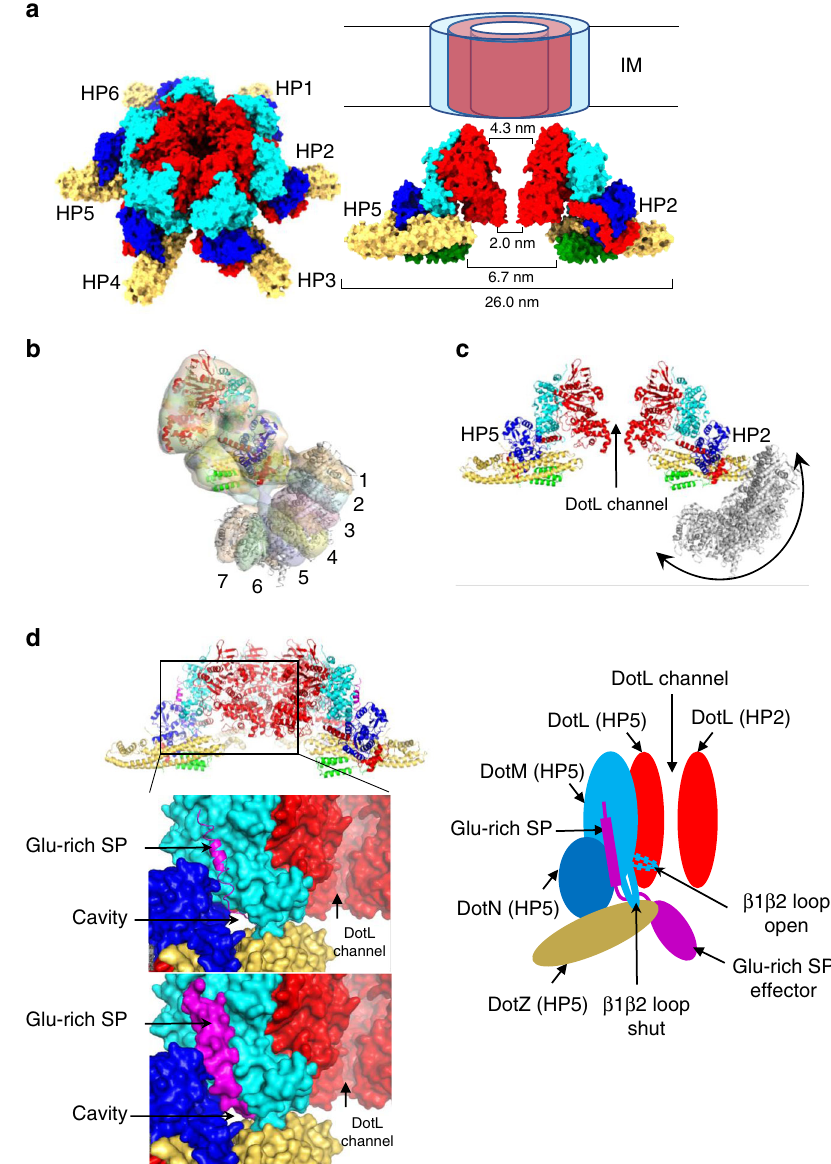
Fig. 5 The T4CC hexamer and effectors recruitment and trajectory. a Tilted and side views of the T4CC hexamer. “ HP ” refers to the hetero-pentameric unit of the T4CC core, 6 units of which form the T4CC hexamer. For the side view, only two hetero-pentameric core units are shown (HP2 and 5). The dimensions of the various parts of the T4CC channel are indicated. Proteins are shown in surface representations color-coded as in Fig. 1e. The trans- membrane segments of DotM and DotL are shown schematically as cylinders inserted through the IM. No structural information is yet available for this channel. b Superposition of 7 maps of the T4CC including IcmSW. The map superposition reports on 7 different positions for the IcmSW module. Map details are reported in Supplementary Fig. 5c. c Superposition of the various IcmSW module structures (in grey ribbon) derived from the maps shown in b in the context of the T4CC hexamer. Two opposite hetero-pentameric units (HP2 and 5) are shown in ribbon color-coded as in Fig. 1e, but only one (HP2) reports on the various IcmSW positions that we observe. The double arrow indicates the trajectory of the IcmSW module, which brings the module in and out of the DotL channel. d Access of Glu-rich SP-containing effectors to the DotL channel. Left, upper panel: location of the region of the T4CC hexamer shown in the two lower panels. Left, lower panels: the surfaces of DotM (cyan), DotN (blue) and DotZ (orange yellow) join up to form a cavity into which the Glu-rich SP bound to DotM (shown in magenta ribbon (upper panel) or surface (lower panel)) inserts. Four DotL subunits are shown in red surface, providing view of the channel within. At right, schematic representation of the view at left, except for the rest of the Glu-rich SP-containing effector being represented at the N-terminus of the Glu-rich SP. The β 1 β 2 loop is labelled and is shut i.e. observed making interactions with the surface of DotZ. For the Glu-rich SP effector bound to DotM (through the Glu-rich SP shown in magenta) to insert within the DotL channel, the loop would need to open (labelled “ open ”